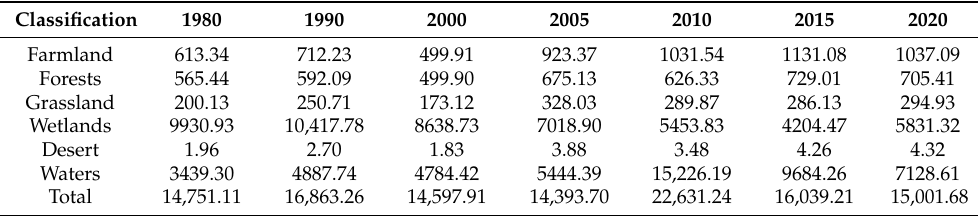
Table 4. Values of ESV in the lakeshore zone of Poyang Lake from 1980 to 2020 (10 6 Yuan).